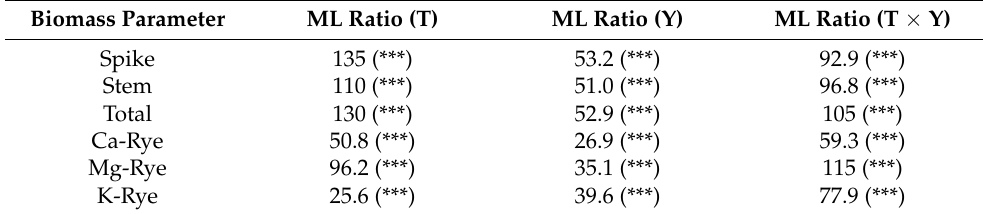
Table 5. Analysis of variance performed on biomass parameters (spike, stem and total biomass; Ca, Mg and K content in stems) at the harvest stage. The variability in the biomass parameters was evaluated using the hierarchical multilevel model (maximum likelihood (ML) ratio). The results were significant at *** p < 0.001. Biomass